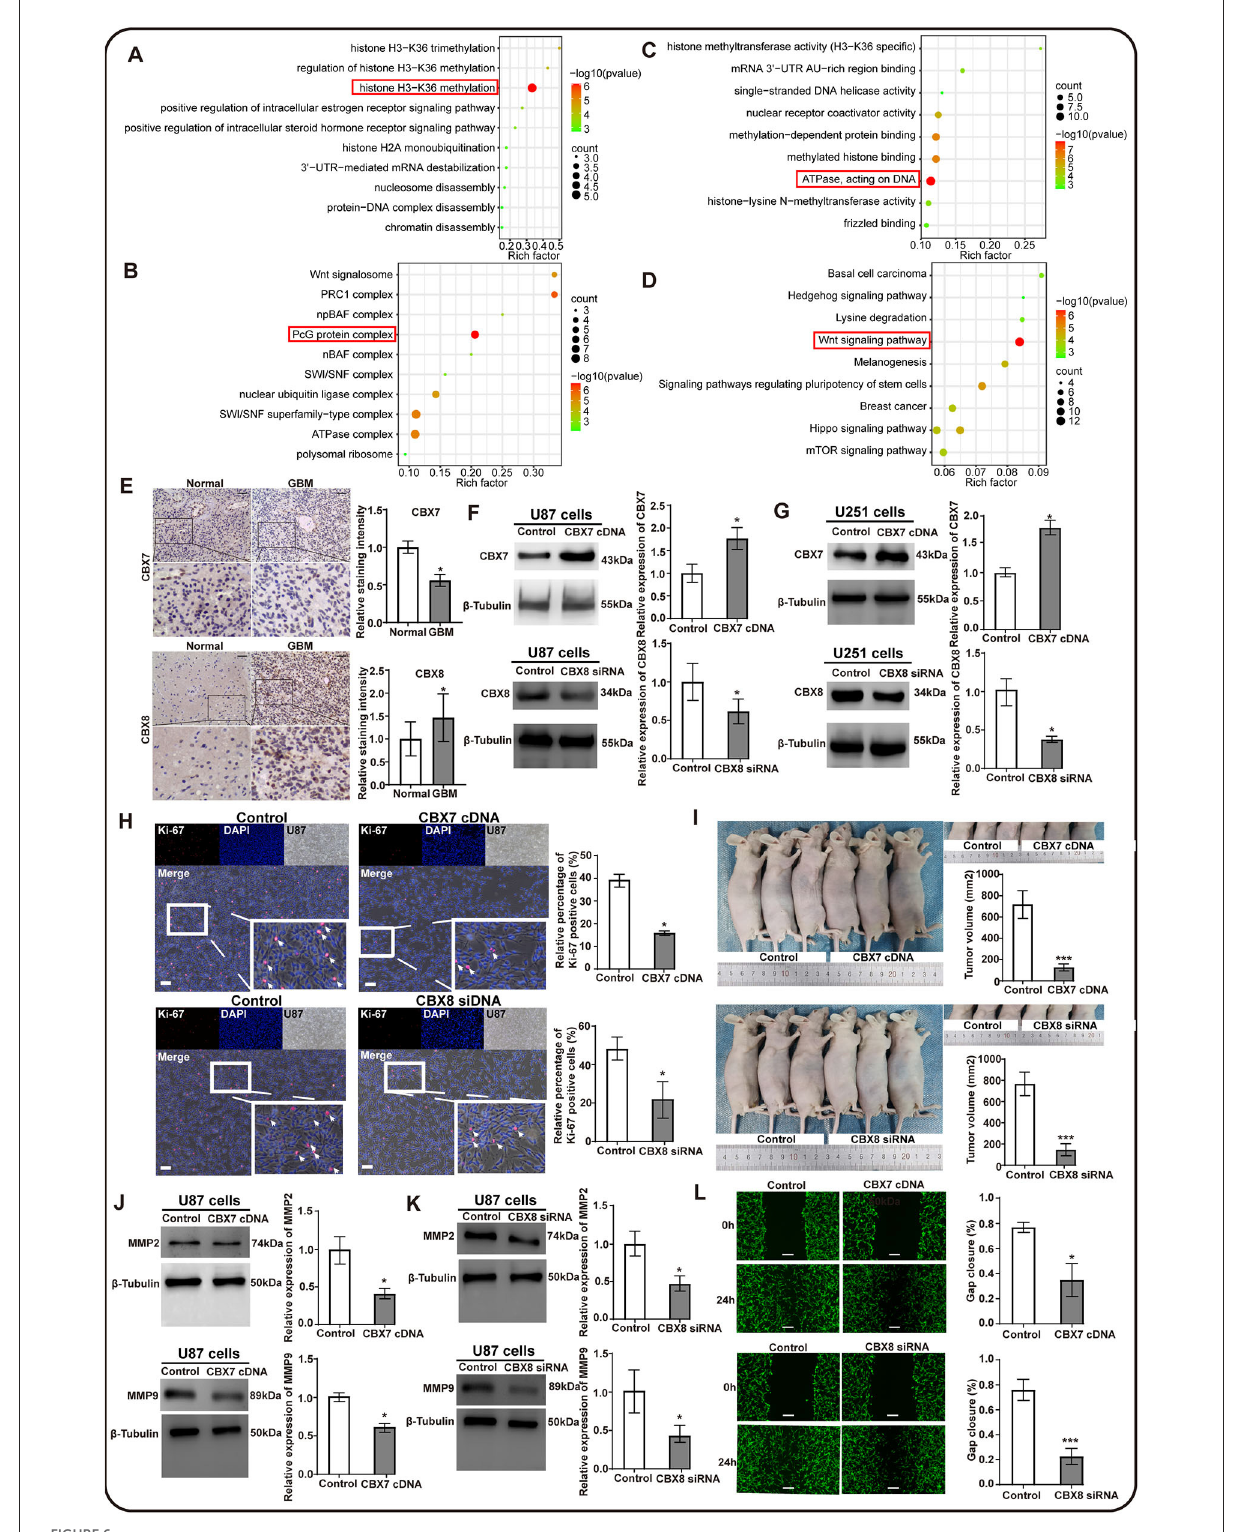
FIGURE6 The potential function prediction and validation of CBX family in proliferation and invasion of glioma cells. The top 50*8 genes associated with CBX members in GBM were screened out by GEPIA and used to conduct the GO and KEGG analyses by Cytoscape. (A) Biological